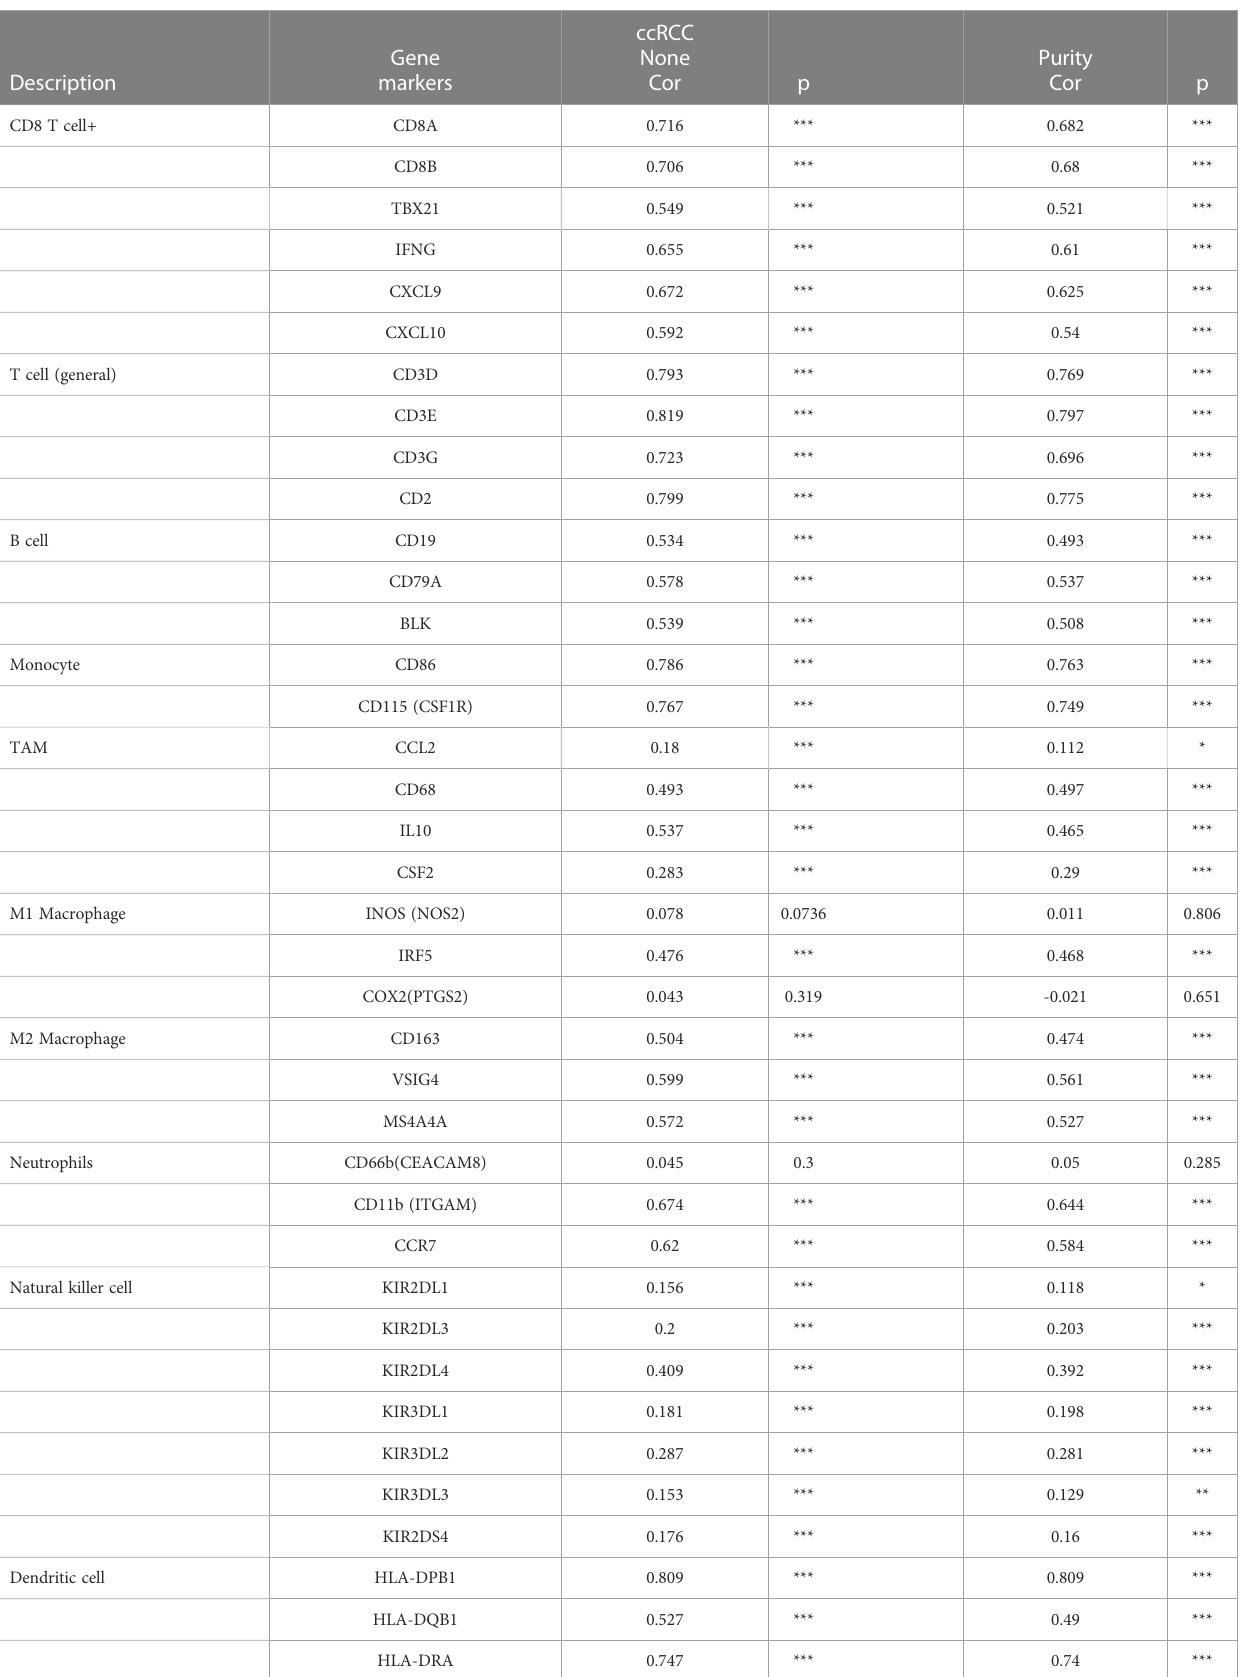
TABLE 2 Correlation analysis between WAS and related genes and markers of immune cells in Tumor Immune Estimation Resource (TIMER2.0).